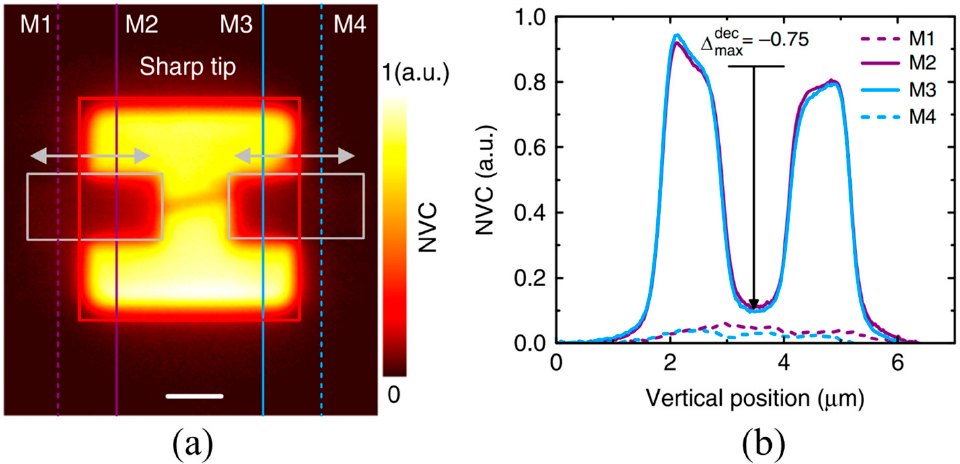
Figure 25. Controlled manipulation of oxygen vacancies. ( a ) The normalized vacancy concentration (NVC) maps after mechanical scans were performed using a sharp tip with a contact force of 9.5 µ N within the grey boxes. Horizontal arrows indicate the corresponding fast scan direction. ( b ) NVC profiles along lines M1, M2, M3, and M4. M1 and M4 are placed 0.5 µ m away from the borders between the V ·· -enriched region (inside the red box) and the pristine region (outside the red box). Horizontal black lines in ( b ) indicate the background, which is used to estimate the net change in the NVC. The NVC profiles were averaged over a 0.5 µ m wide averaging window. Reprinted with permission from [101]. Copyright 2020 Springer Nature.